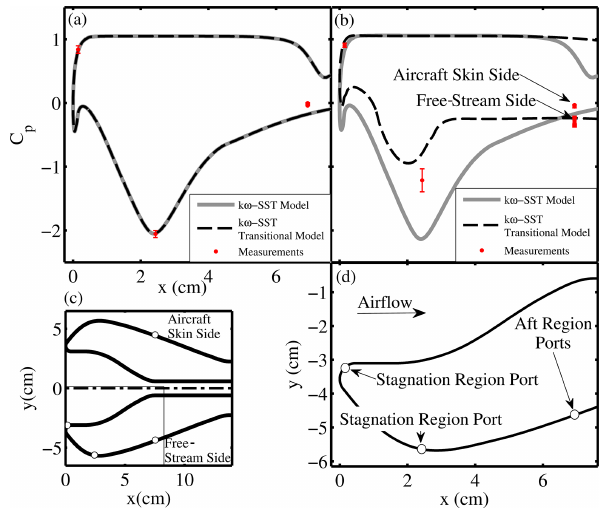
Figure 5. Comparison of pressure measurements around the blunt body housing with simulation results. The experimental data are from the PLOWS research flight PLOWSrf01, 13 November 2009